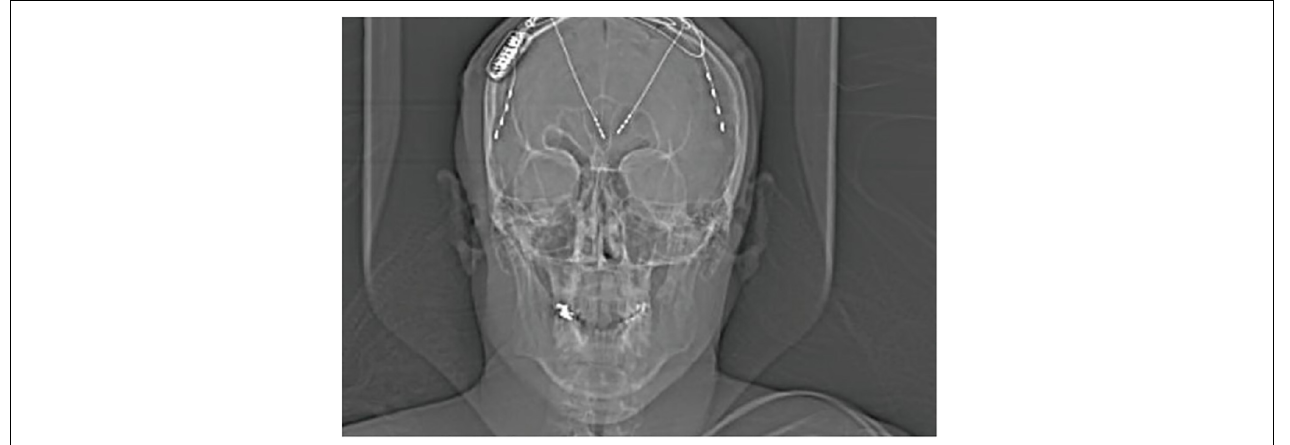
FIGURE 2 | X-ray displaying the implantation of RNS device with 2-depth electrodes each with four contacts targeting the ANT and 2-strips in the prefrontal cortex of a 34-year-old patient with genetic generalized epilepsy; only the right ANT depth and right cortical strip were attached to the RNS device. Adapted with permission from Herlopian et al.